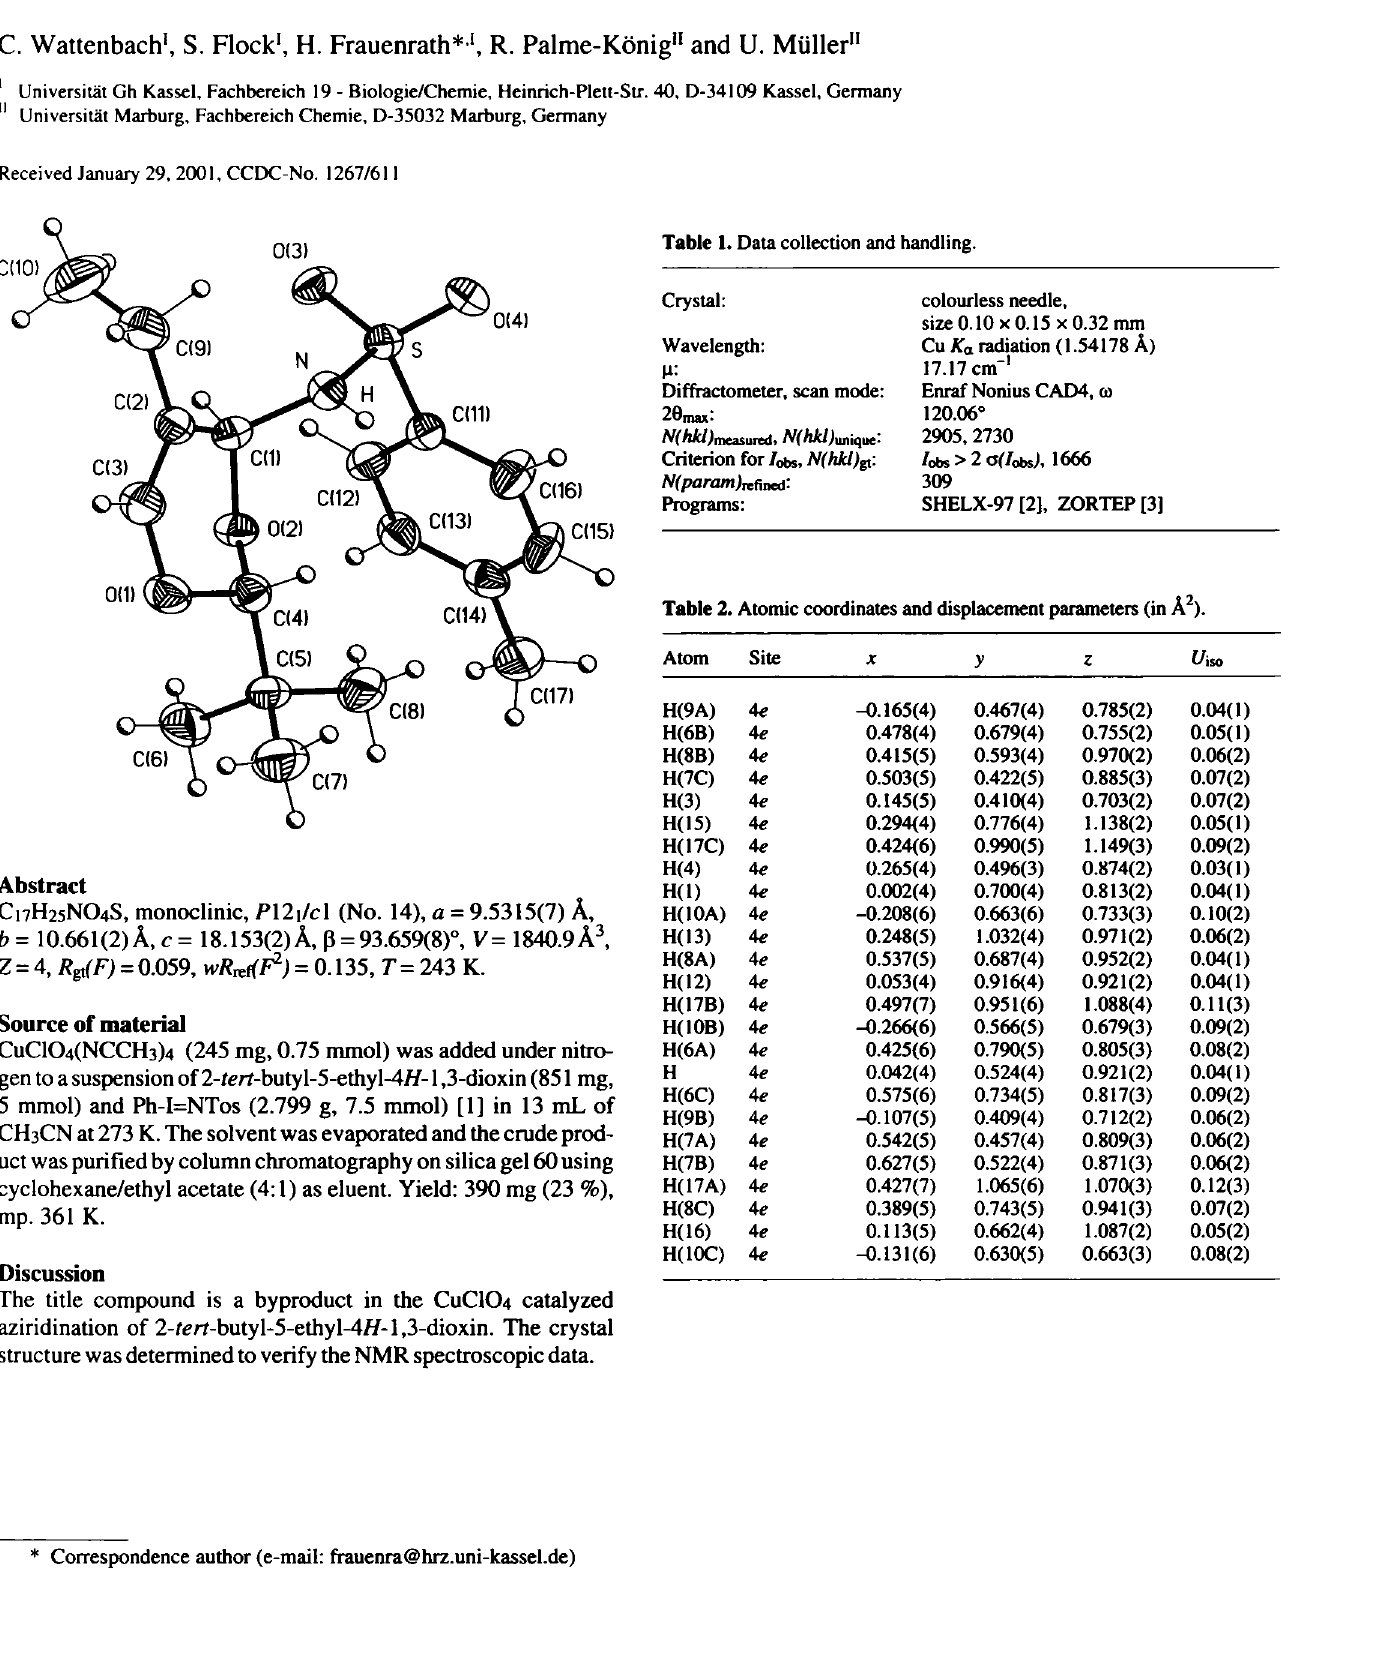
Table 1. Data collection and handling.